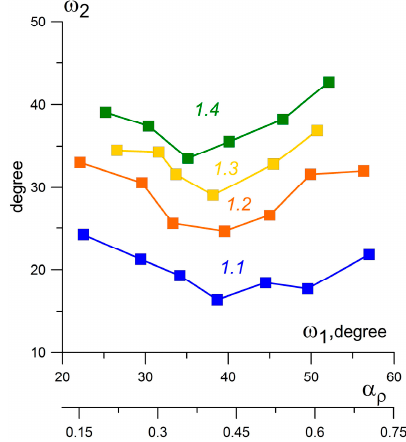
Figure 7. Dependence of the angle ω 2 on ω 1 and α ρ for different γ .